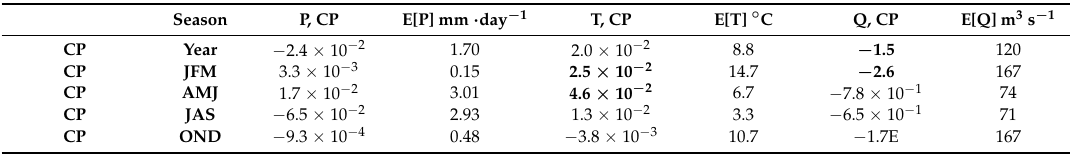
Figure 7. Projected trends of discharge yearly and seasonal discharge Q, precipitation P, temperature T until 2100 as per RCPs vs. CP period. CM period (bars below), and PR period (bars above). Average RCP values reported with maximum and minimum (i.e., among GCMs). Table 4. Trends of climate and hydrology for CP, PR, and CM periods. In CP periods, average values are reported. In bold significant values ( α = 5%).